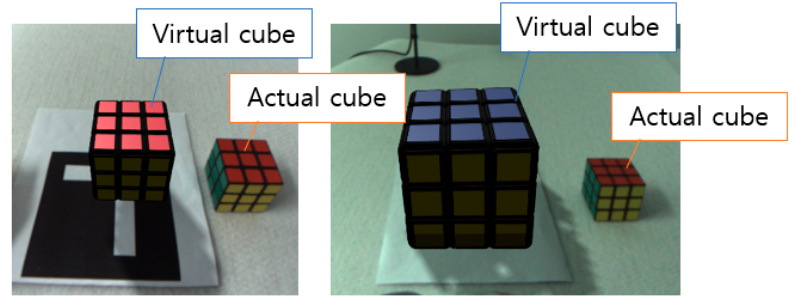
Figure 4. Experimental design. A participant compared the size of the virtual cube with the actual cube in the experiment.